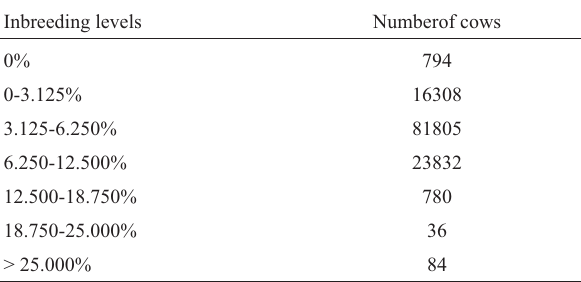
Table 1 - Classification of inbreeding into seven levels, and the number of cows per category.